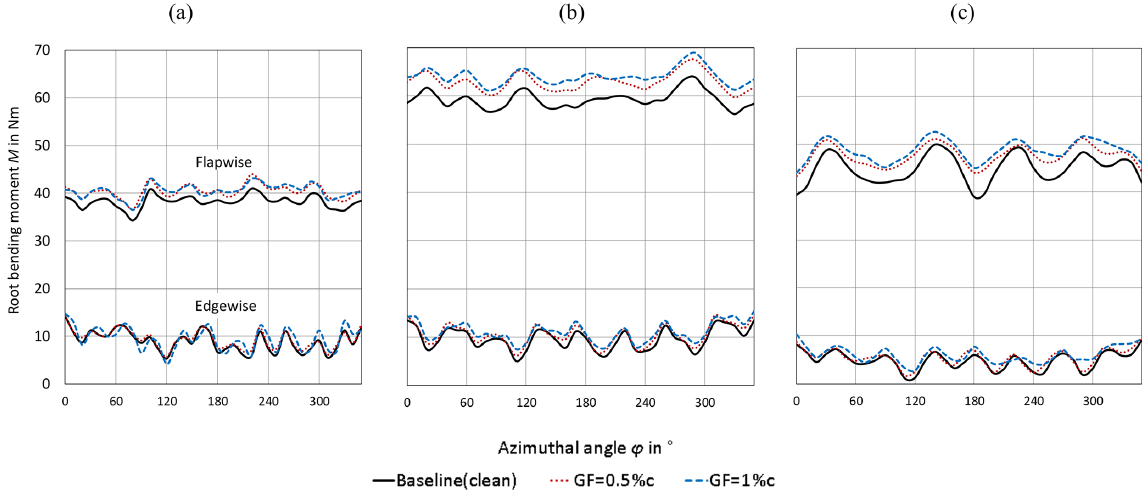
Figure A4. Flapwise and edgewise root bending moments in the clean case. (a) TSR = 3.0. (b) TSR = 4.3. (c) TSR =